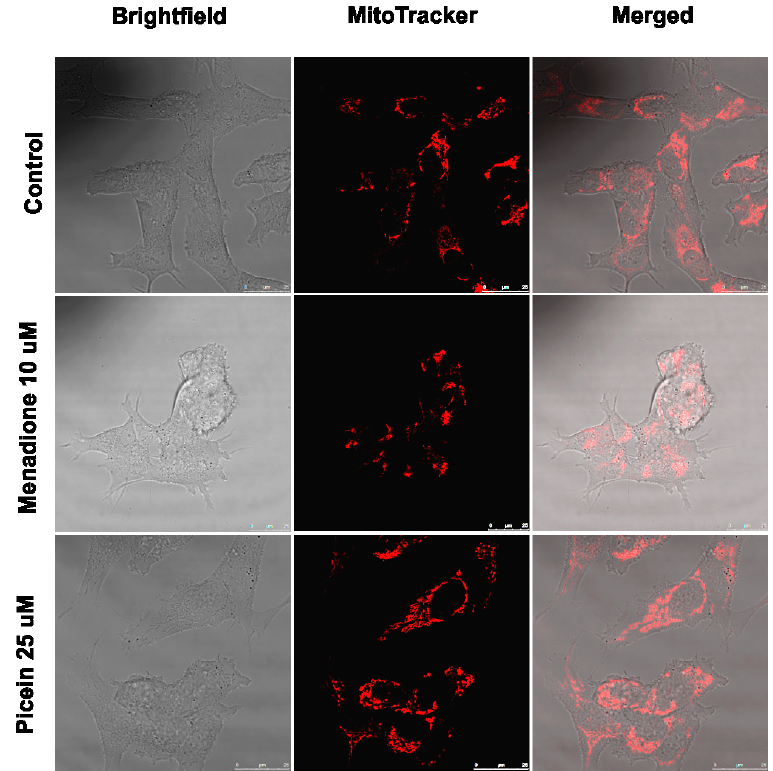
Figure 7. Live cell microscopy of human SH-SY5Y neuroblastoma cells immediately after menadione (MQ) exposure and follow-up treatment with picein. All images were taken with a 63X water objective. Images were taken in brightfield and Mitotraker mode. Further merged these images to see the morphological differences among control, menadione (10 µ M) and follow-up treatment with picein (25 µ M).